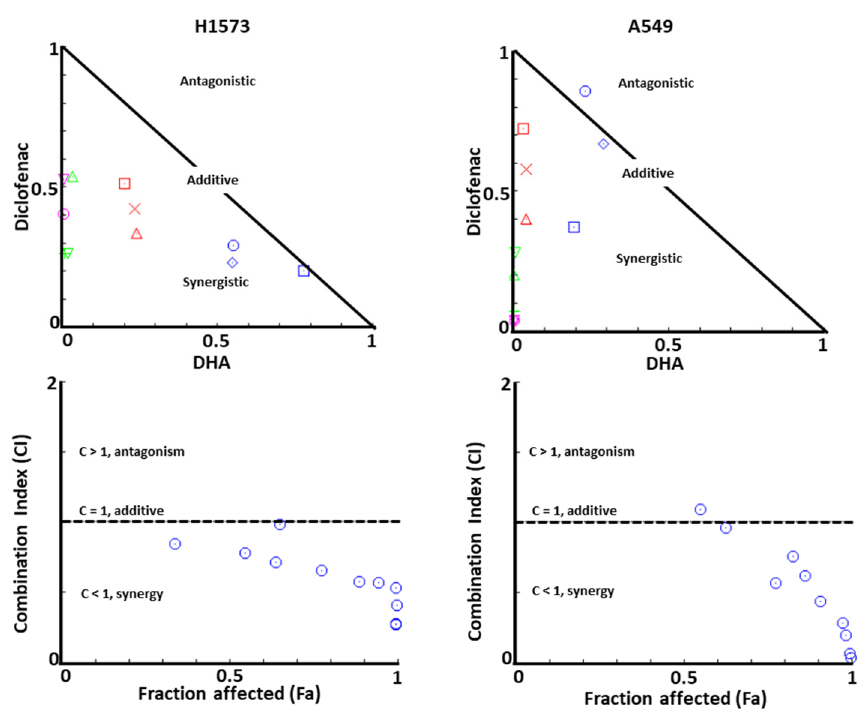
Figure 3. Normalized isobologram of combined treatment of DHA and diclofenac on NCI-H1573 and A549 human lung cancer cells. The combination index for DHA and diclofenac on NCI-H1573 cells were analyzed using CompuSyn software. The different colored symbols represent fractional activities for different concentrations of DHA and diclofenac used in the experiment. CI < 1, = 1, and > 1 indicates synergistic, additive, and antagonistic effects, respectively.